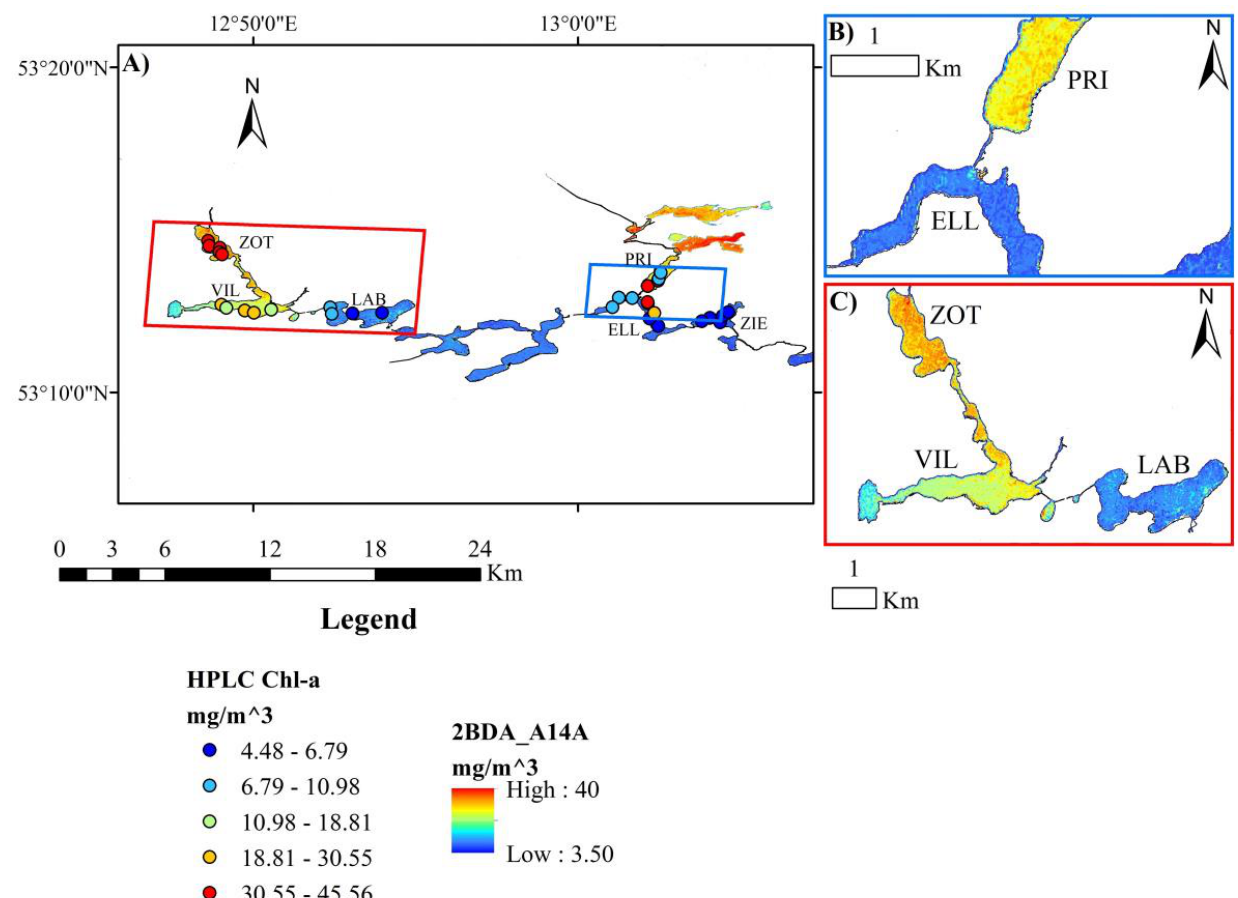
Figure 9. Estimated chl- a concentrations from Sentinel-2/MSI image acquired on 26.07.2019 using the 2BDA bio-optical algorithm with the A14A calibration. Color indicates the estimated chl- a concentration while circles indicate the measured chl- a concentration. ( A ) Deep Müritz-Havel Lakes; ( B ) Zoom view of Großer Priepertsee (PRI) and Ellbogensee (ELL) connection; ( C ) Zoom view of Zotzensee (ZOT), Vilzsee (VIL) and Labussee (LAB).